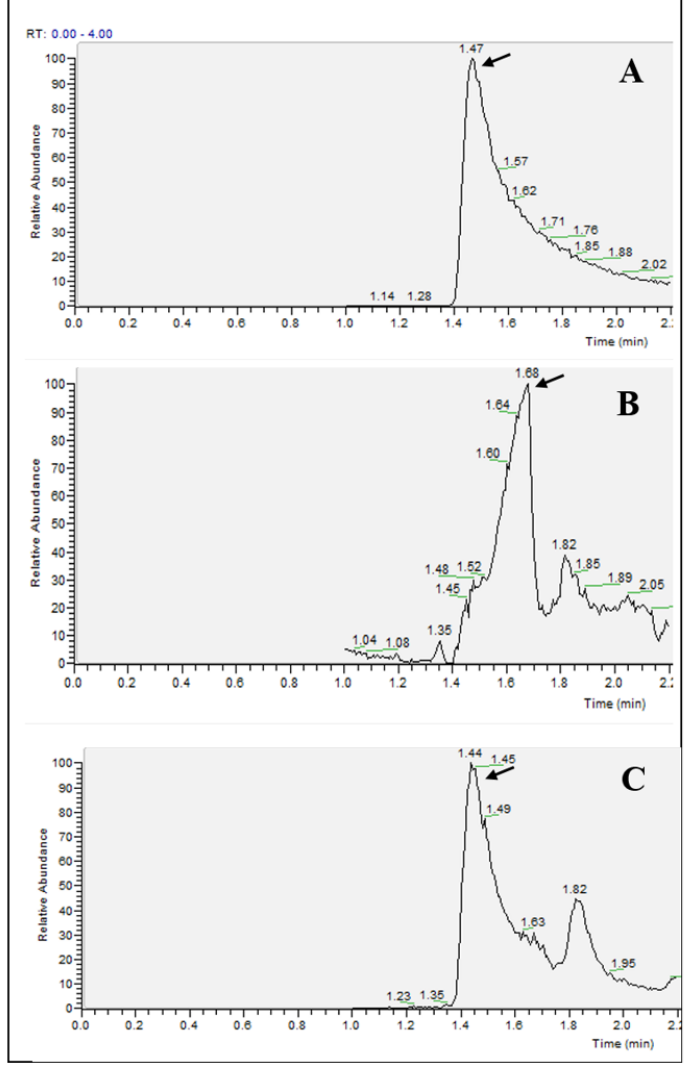
Figure 7. Extracted mass chromatogram base on m/z 330 ( A ) standard 500 nM 2OH-E + , ( B ) non diluted human plasma and ( C ) human plasma diluted 100 times .